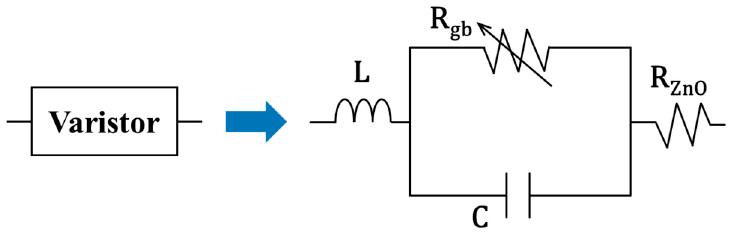
Figure 2. Equivalent circuit of the varistor.